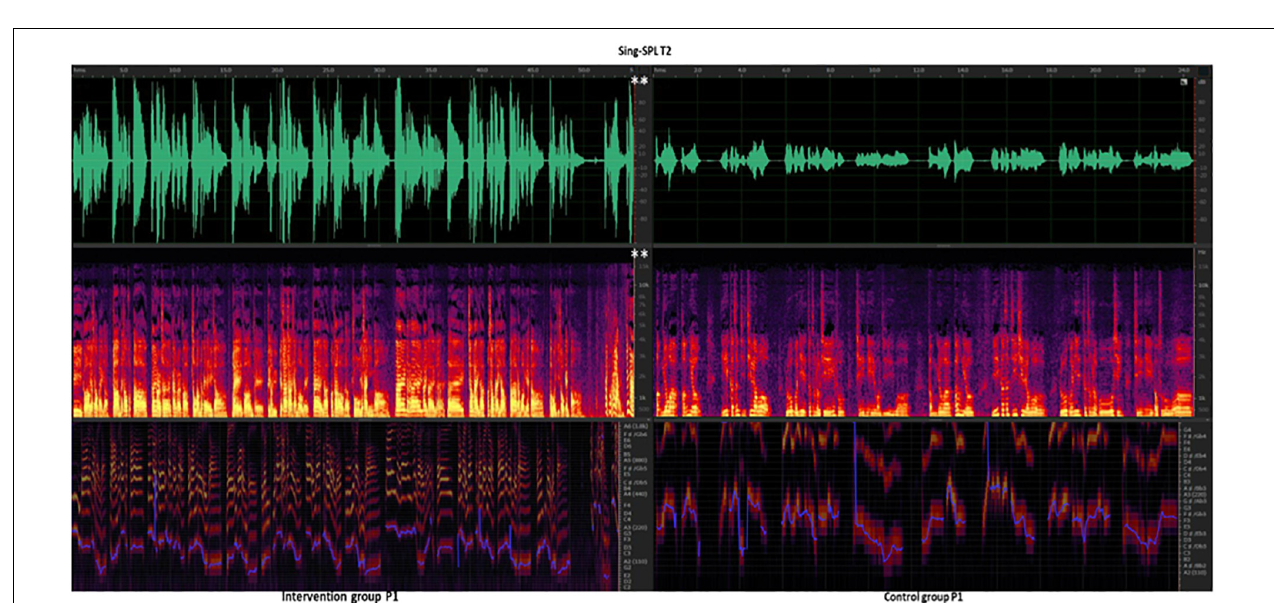
FIGURE 8 | Comparison of sound frequencies (F0, Hz) at three points in time at T0, T1, and T2 in the intervention group performing vocal therapy (VIT) with the control group for respiratory pronunciation training. Intervention group, intervention group, indicated in red. Control group, control group, black indicates. (A) Individual difference distribution of F0 values at T0 time point between patients in the intervention group ( n = 9) and patients in the control group ( n = 9). (B) The individual difference distribution of the F0 values of the patients in the intervention group ( n = 9) and the control group ( n = 9) at the T1 time point. (C) Individual difference distribution of F0 values at T2 time points between patients in the intervention group ( n = 9) and patients in the control group ( n = 9). Hz, Hertz; n, the number of participants; T0, baseline; T1, after 6 weeks; T2, after 12 weeks. ∗∗ p < 0.01, with significant differences between groups.